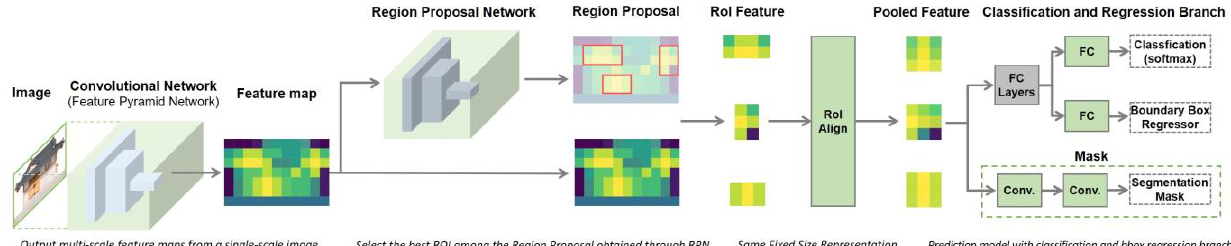
Figure 13. Structure of Mask R-CNN.